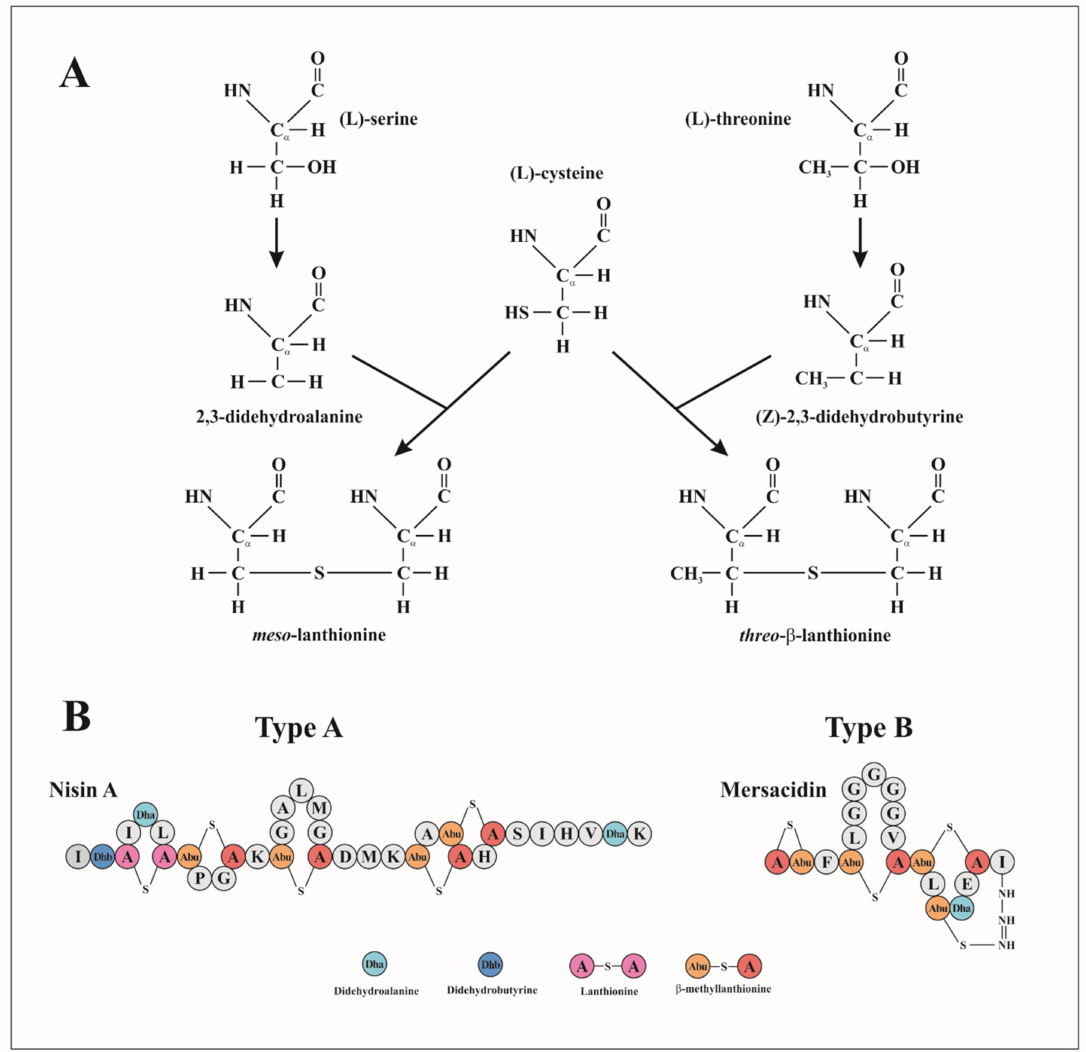
Figure 2. ( A ) Biosynthesis of the thioether lanthionines during lantibiotic maturation. Dha (2,3-didehydroalanine) and Dhb (2,3-didehydrobutyrine) are obtained from the dehydration of L-serine and L-threonine, respectively. Then, Dha and Dhb react with L-cysteine to form a Lan thioether resulting in lanthionine ( meso -lanthionine) and β -methyllanthionine ( threo - β - lantionine), respectively. Lantibiotics are divided in two types, A and B. ( B ) Molecular structure of nisin A (type A), and mersacidin (type B), where the modified amino acids are highlights in different colors. Adapted from McAuliffe et al.